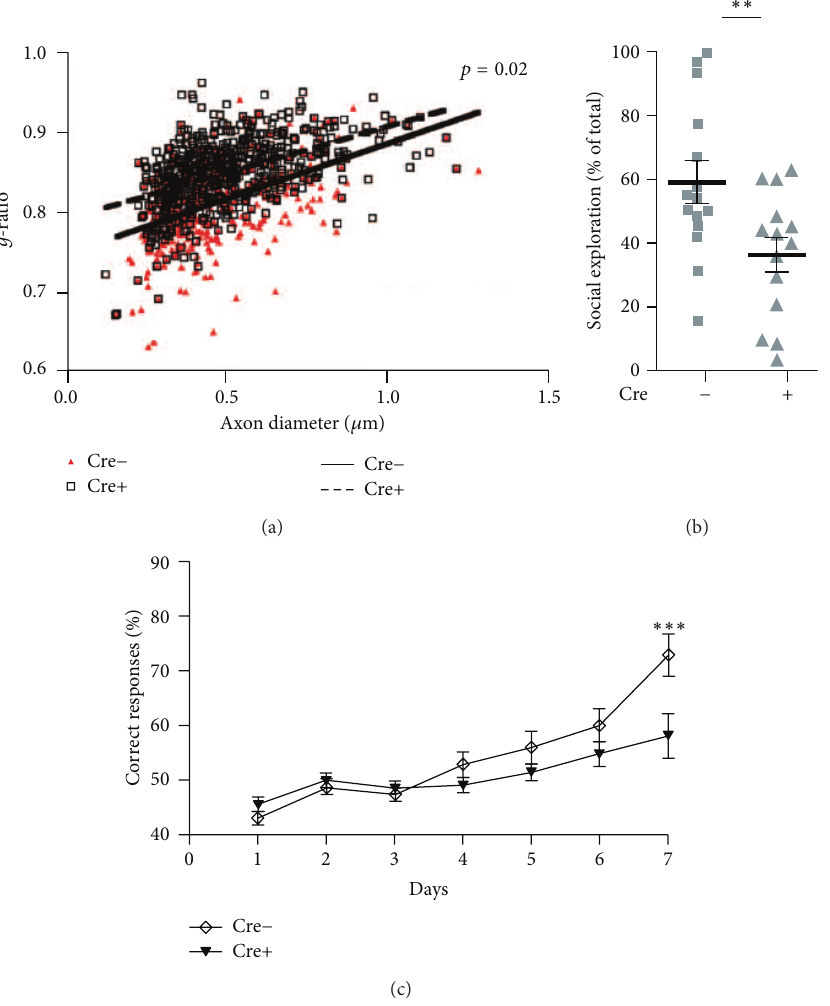
Figure 2: Modified from Makinodan et al., Science [28]. (a) Myelin thickness. (b) Sociality. (c) Working